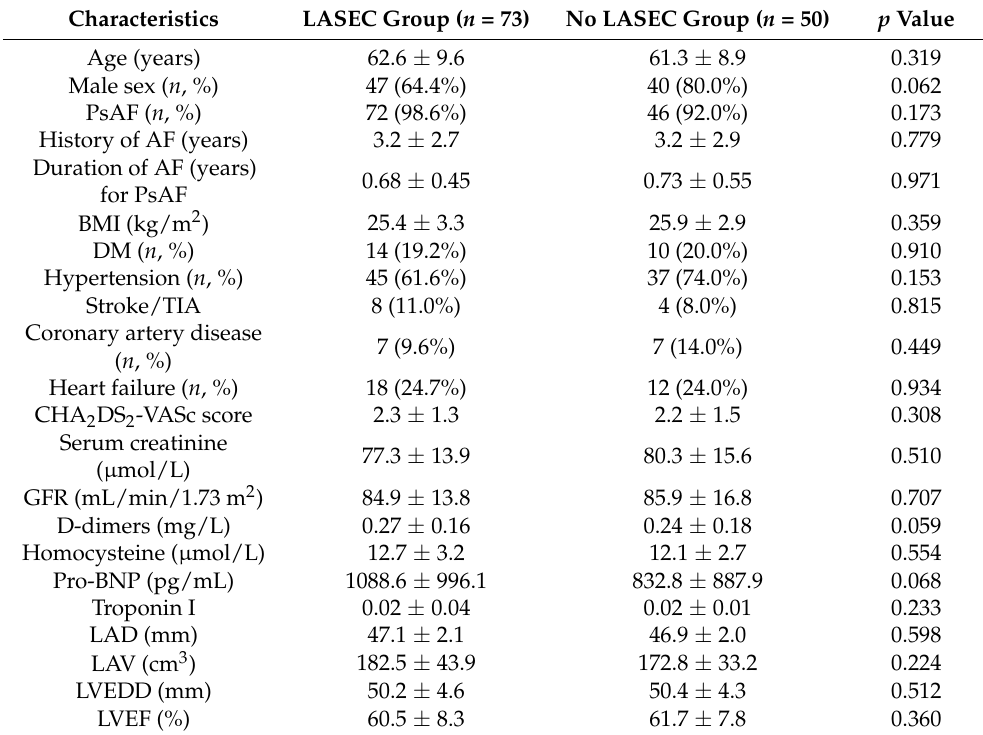
Table 1. Baseline demographic characteristics.